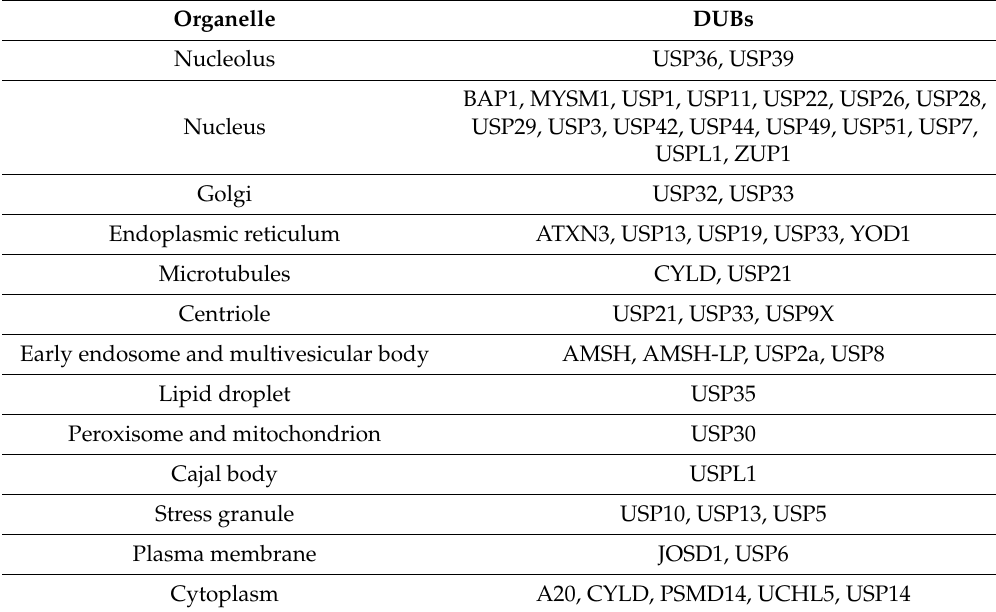
Table 1. The sub-cellular localizations of DUBs in mammalian cells.